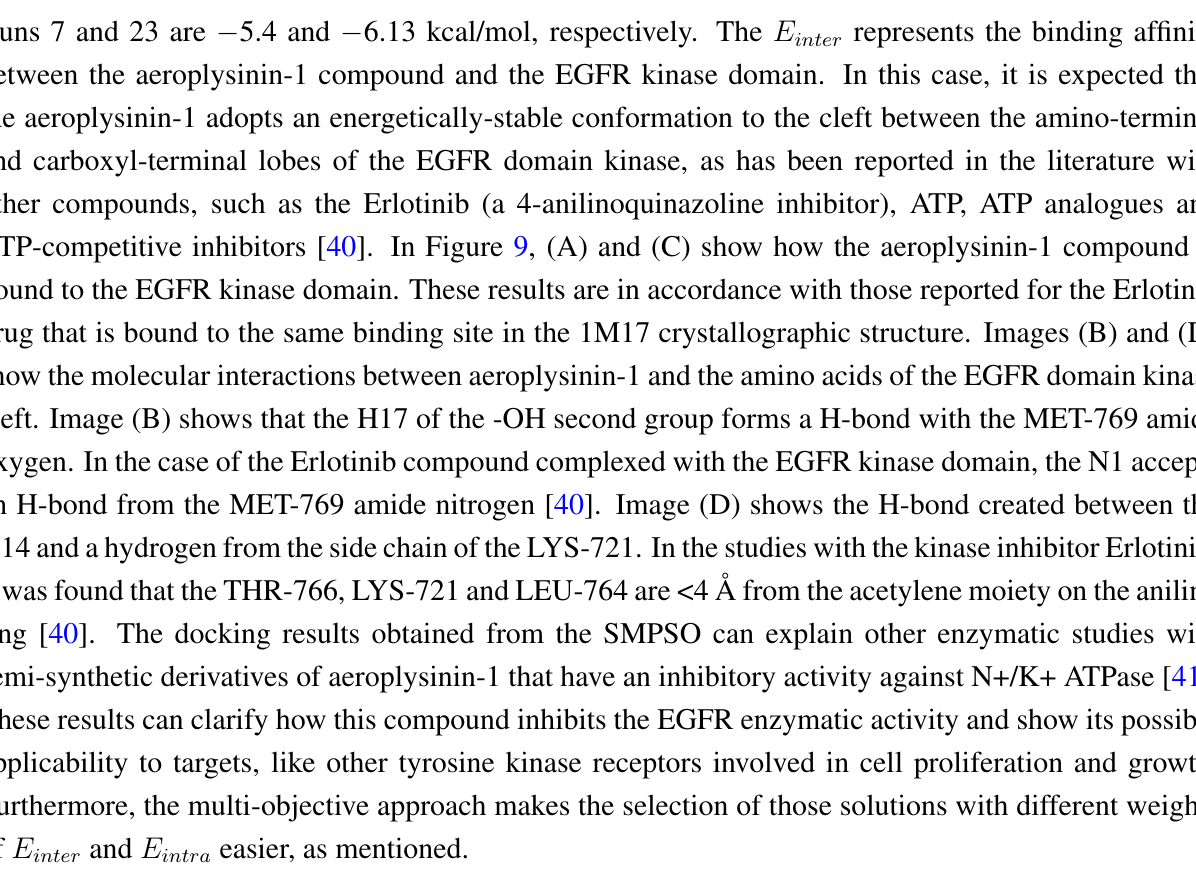
and E values are inter intra and E equal − 6.13 and inter intra